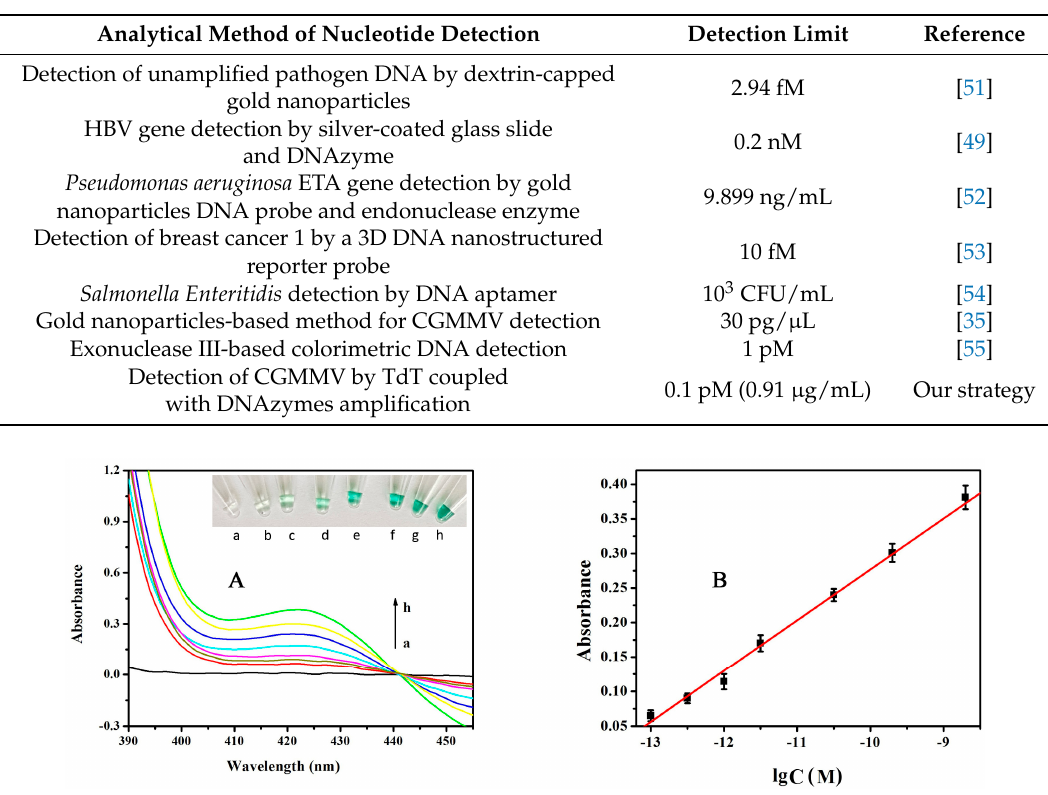
Table 2. Comparison of visually related sensors for nucleotide sequence detection.